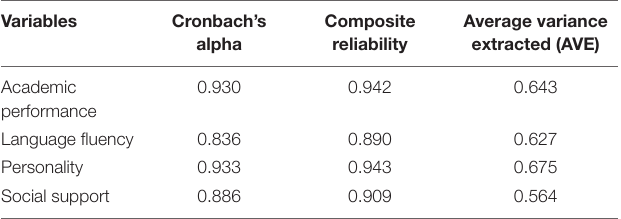
TABLE 3 | Construct validity and